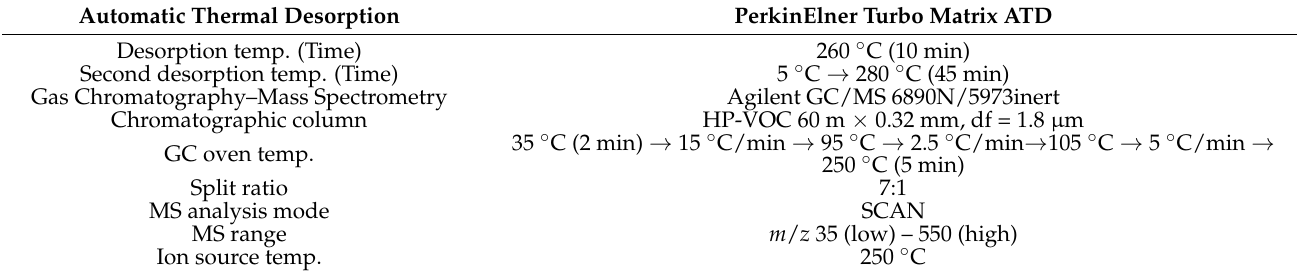
Table 3. The conditions of